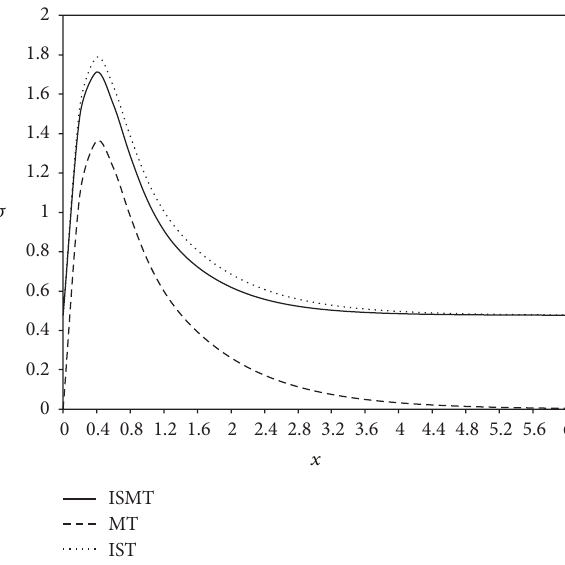
Figure 6: Stress distribution 𝜎 at 𝛼 = 0.5 , 𝑡 = 0.1